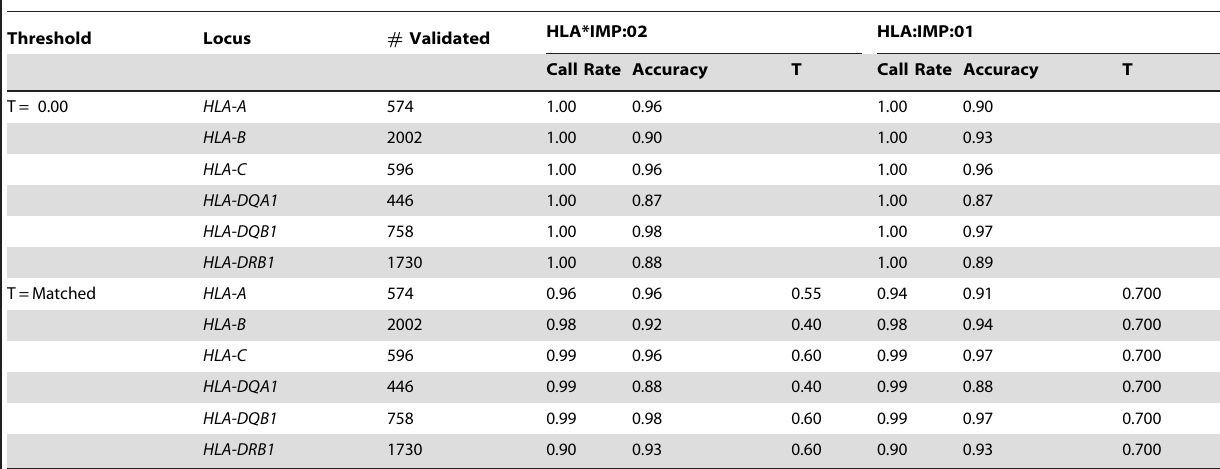
Table 2. Baseline validation on a homogeneous reference panel.